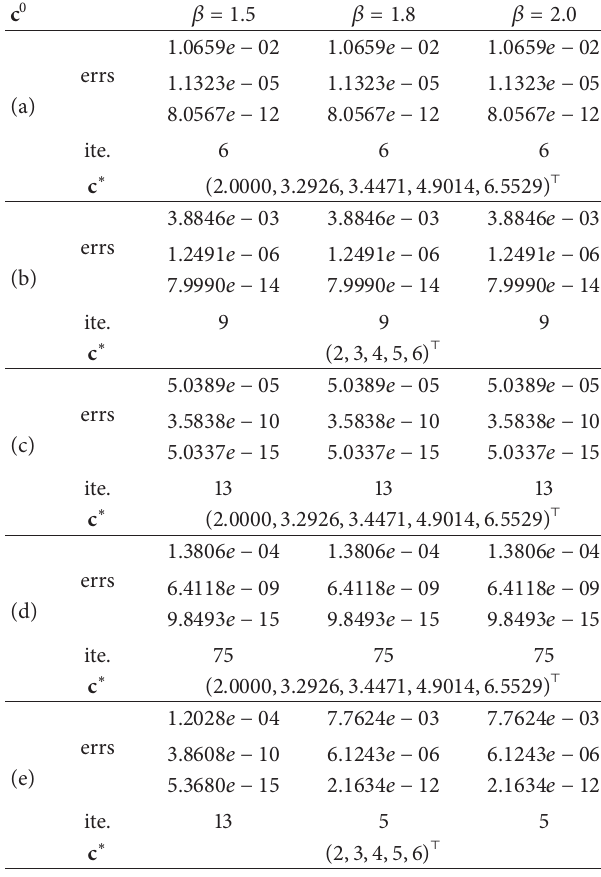
Table 1: Numerical results for Example